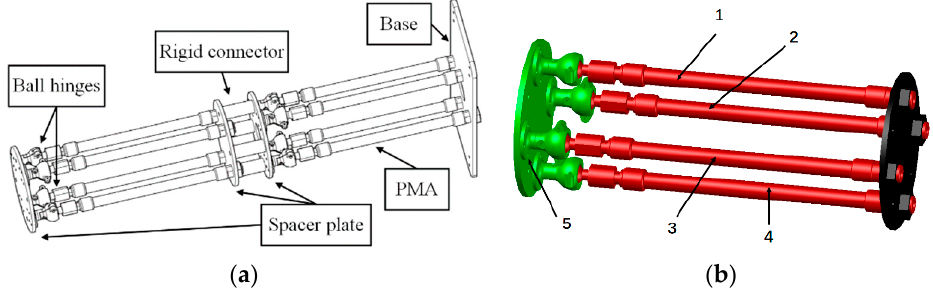
Figure 1. ( a ) Multisection continuum arm structure. ( b ) Single continuum node structure.